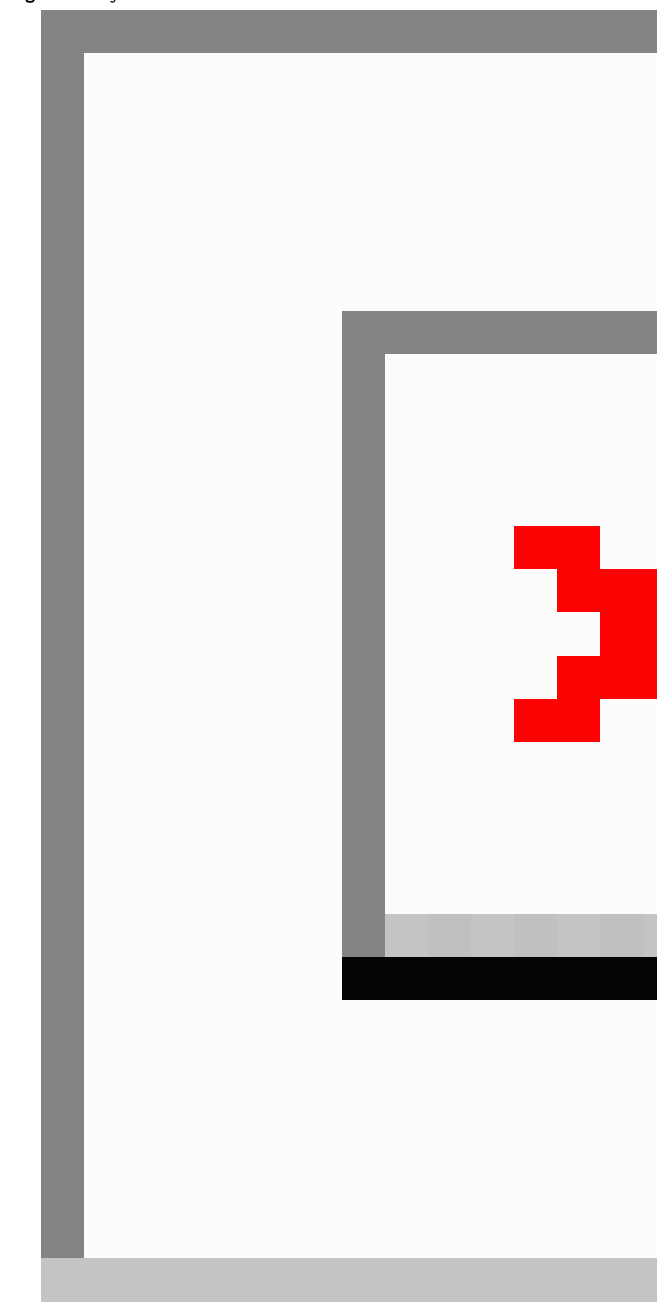
Figure 1. Systematic review of the literature